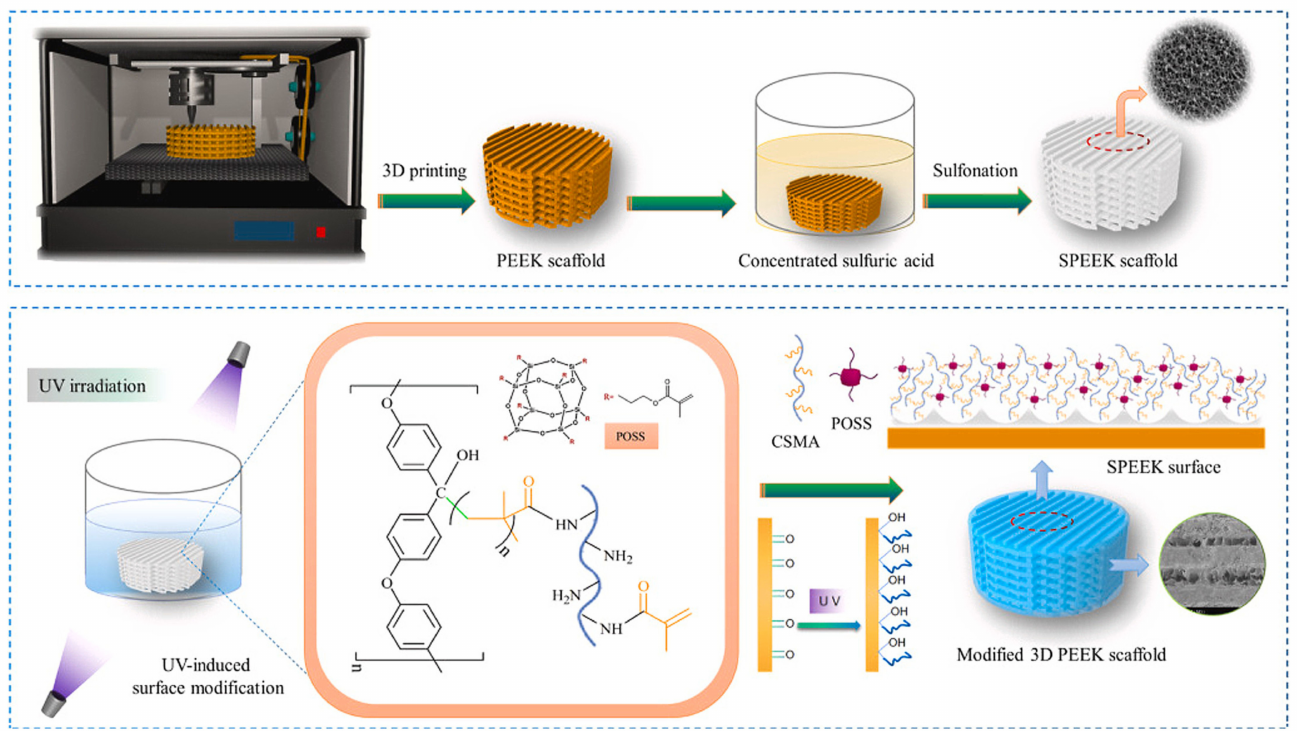
Figure 9. Schematic illustration of PEEK/POSS fabrication procedure. Reprinted with permission from: Liu, Z.; Zhang, M.; Wang, Z.; Wang, Y.; Dong, W.; Ma, W.; Zhao, S.; Sun, D. Compos. Part B Eng. 2022 , 230 , 109512